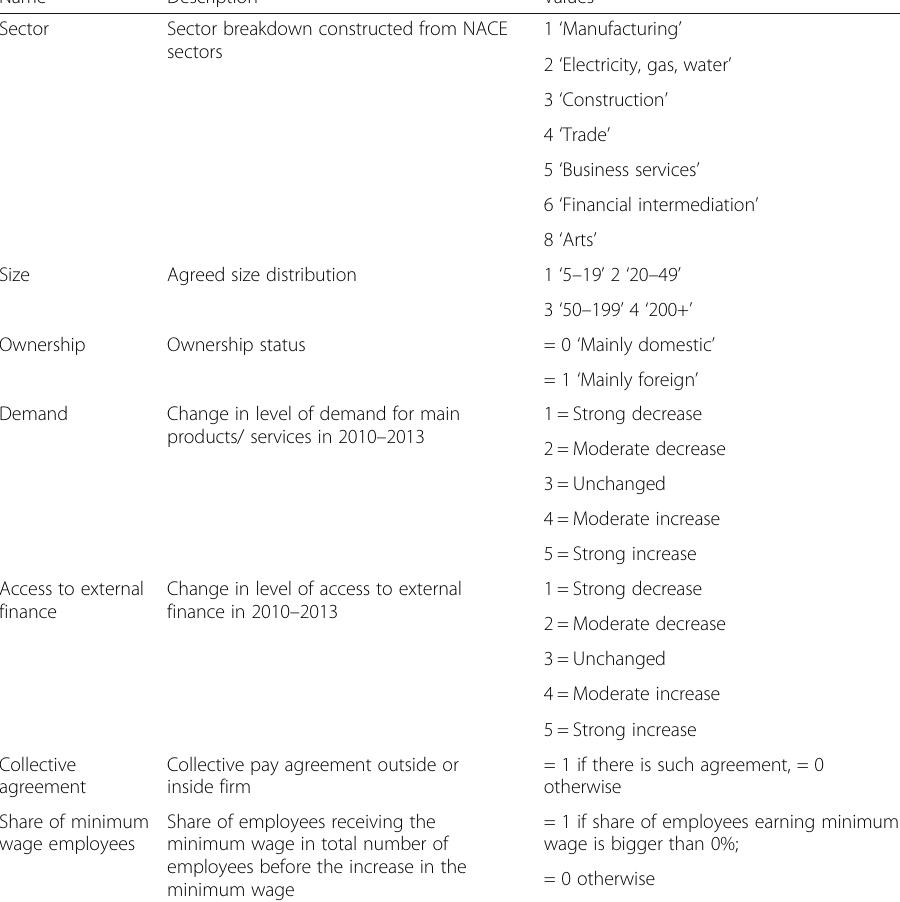
Table 11 Explanatory variable